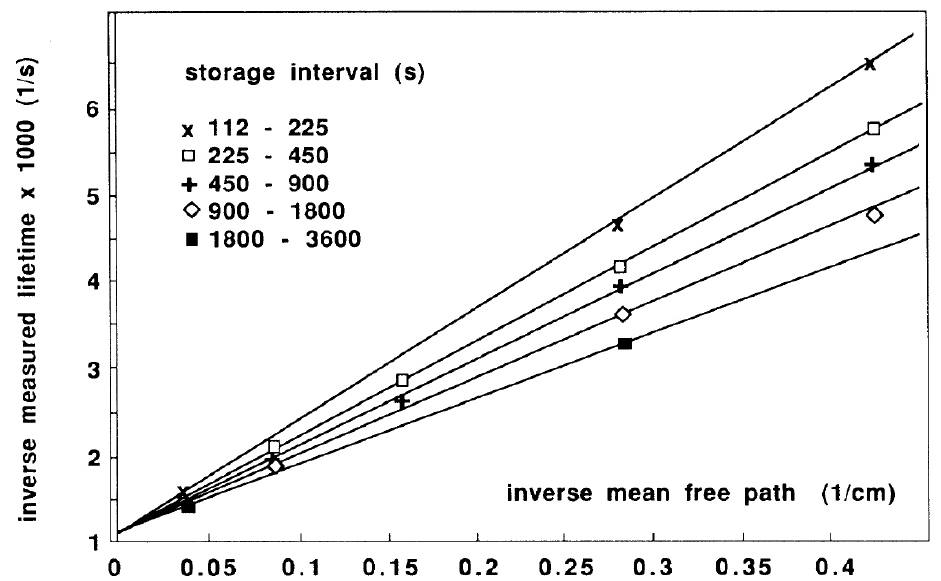
Figure 2. The remarkable result of the first high-precision experiment (MAMBO) [25] using the mfp scaling technique is shown. The figure is reproduced from Fig. [2] of Ref.